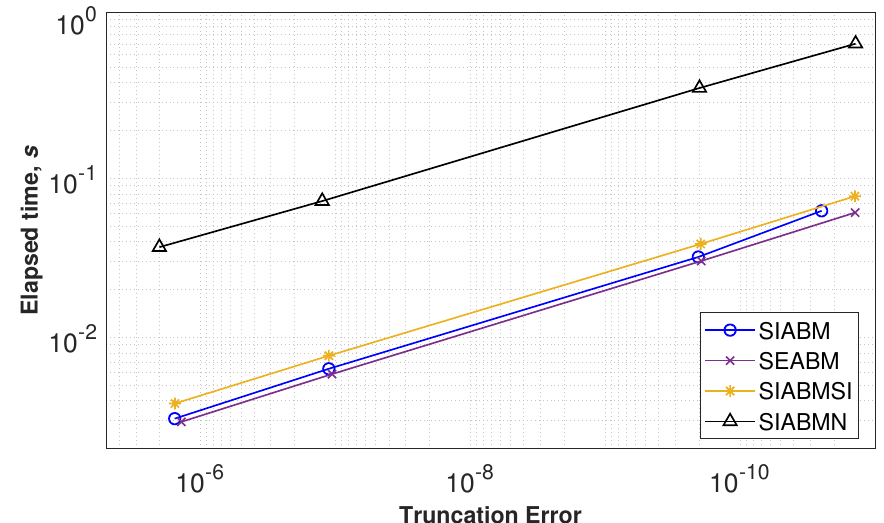
Figure 5. Performance plots for various semi-implicit and semi-explicit multistep ODE solvers simulating system (7) with fixed